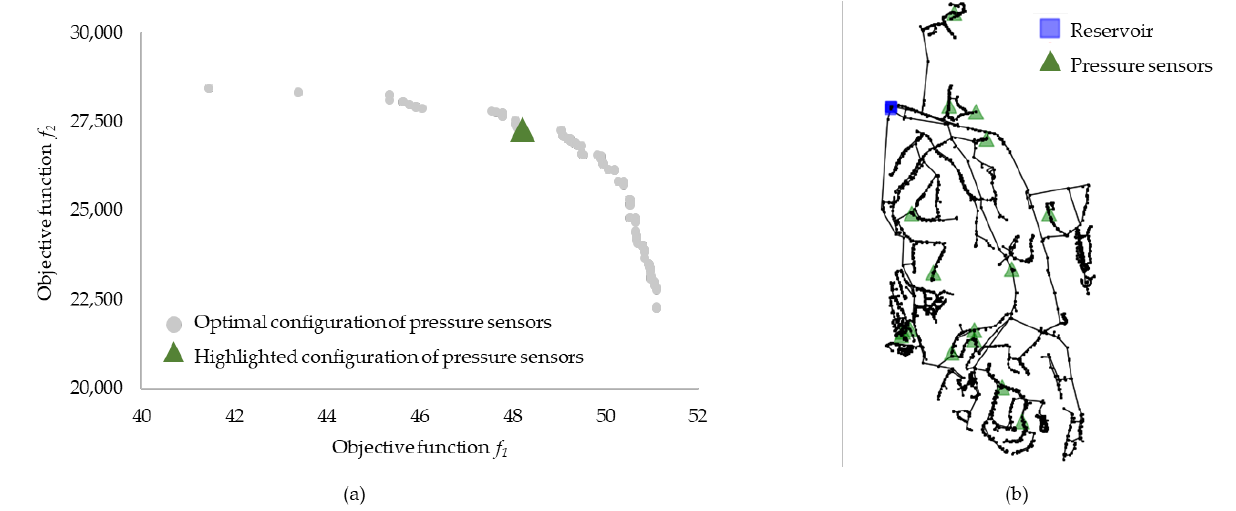
Figure 9. ( a ) Pareto front for 16 sensors; ( b ) optimal pressure sensor location for 16 sensors.